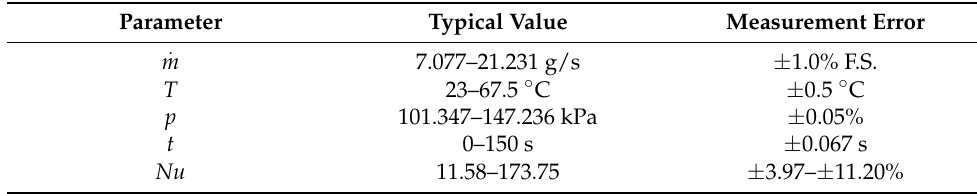
Table 1. Uncertainty of